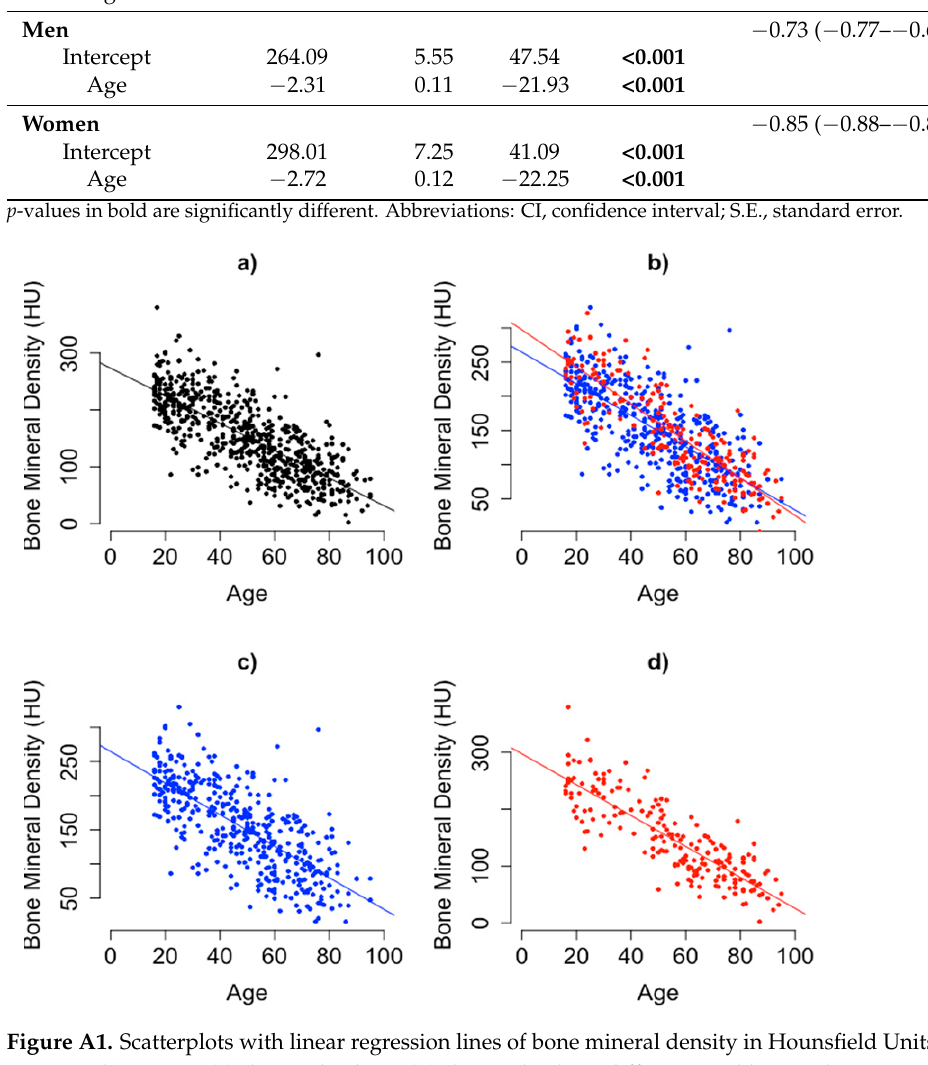
Figure A1. Scatterplots with linear regression lines of bone mineral density in Hounsfield Units (HU) compared to age in ( a ) the total cohort, ( b ) the total cohort differentiated by gender (men in blue, women in red), ( c ) only men, and ( d ) only women.